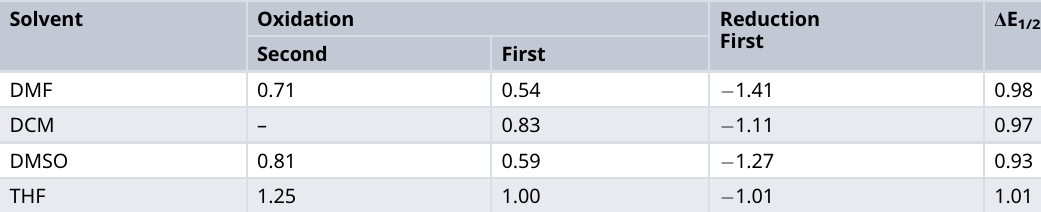
Table 2. Determination of half-wave potentials for four different